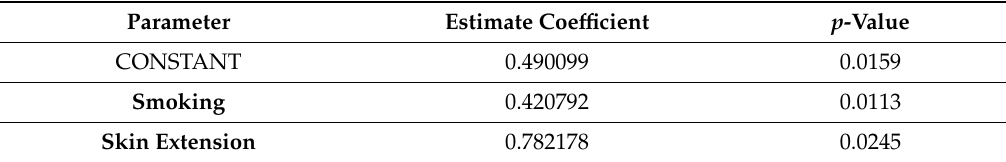
Table 4. Multiple regression analysis of factors associated with the oxidative score in Crohn’s